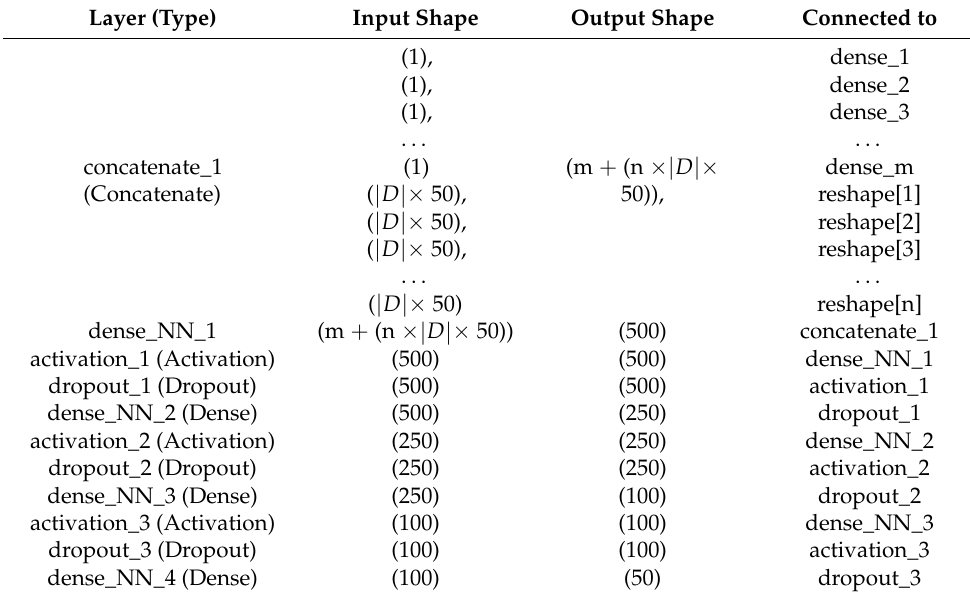
Table 3. Input and output shapes and connectivity of MLP with Data-Aware Entity-Embedding